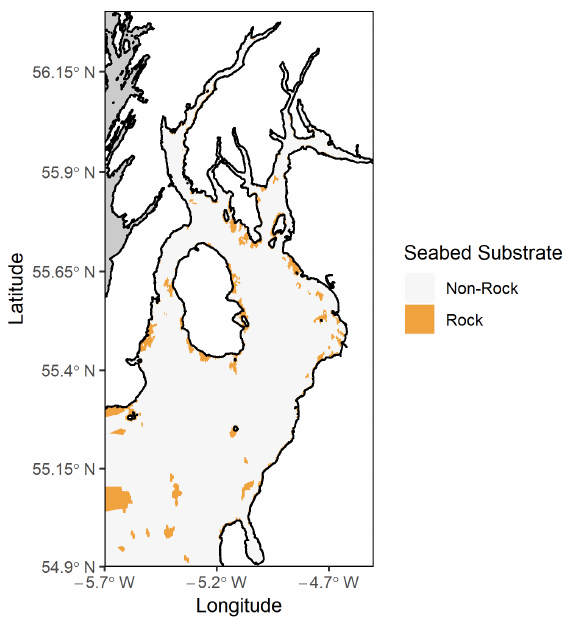
Figure 6. Distribution of hard substrate in the Firth of Clyde ac- cording to BGS data layers and random forest model predictions generated for areas lacking data – the inner Firth of Clyde and sea lochs.